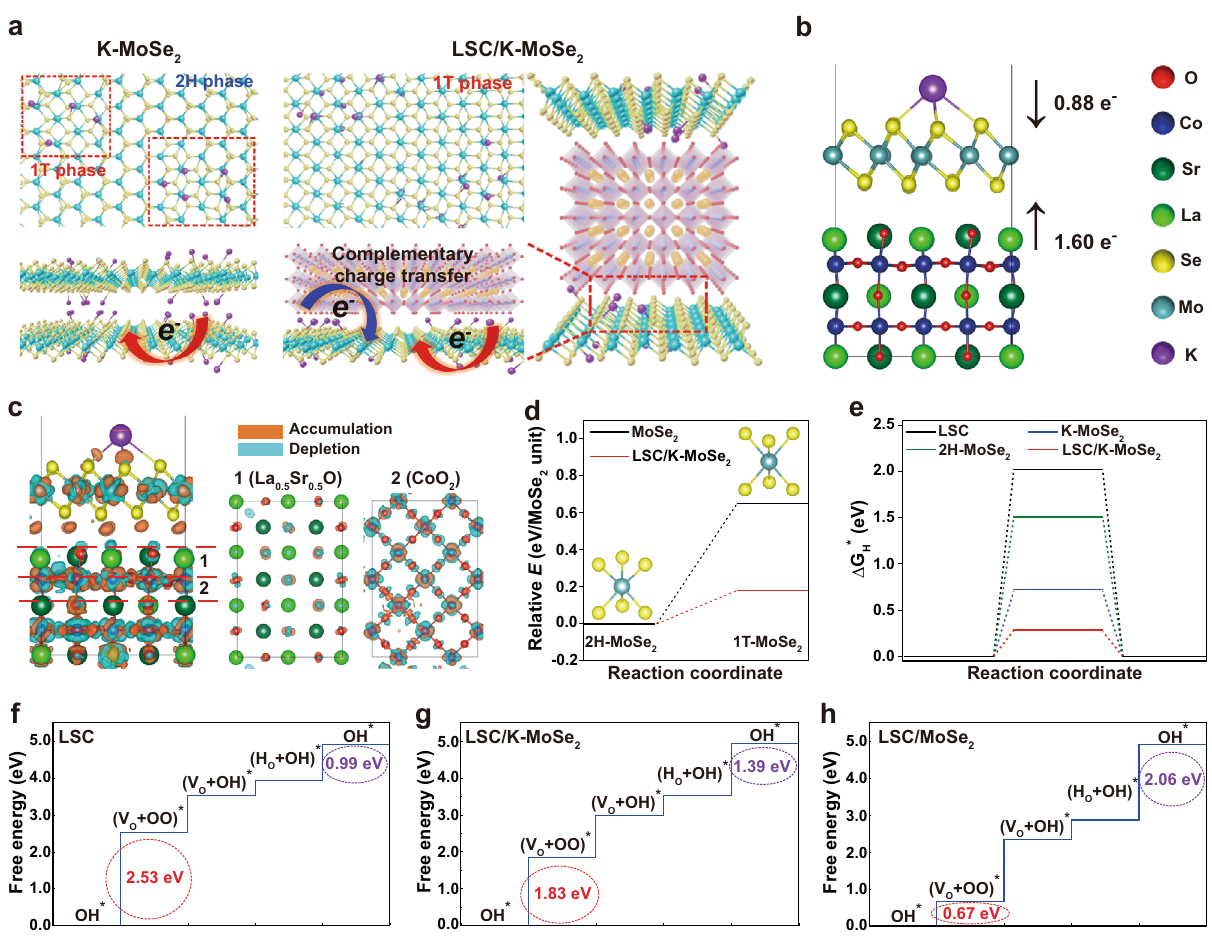
Fig. 4 Complementary charge transfer phenomena in bifunctional LSC/K-MoSe 2 catalysts. a Schematic of the atomic structure and charge transfer effect for K-MoSe 2 and LSC/K-MoSe 2 . Complementary charge transfer in LSC/K-MoSe 2 can modulate the electronic structure of MoSe 2 , increasing the 1T- MoSe 2 ratio in the heterostructure. b Charge transfer from K and LSC to MoSe 2 in the optimized LSC/K-MoSe 2 heterostructure. c Charge density difference plot for the interface between LSC and K-MoSe 2 . Side view of the total structure (left) and the cross section of the layers of La 0.5 Sr 0.5 O (middle) and CoO 2 (right) are demonstrated. d Relative energies of 1T-MoSe 2 in monolayer structure (black line) and LSC/K-MoSe 2 heterostructure (red line) compared to the energy of the 2H-MoSe 2 monolayer. e Free energy diagrams for HER for LSC, 2H-MoSe 2 , K-MoSe 2 , and LSC/K-MoSe 2 . f – h Free energy diagrams for OER for LSC, LSC/K-MoSe 2 , and LSC/MoSe 2